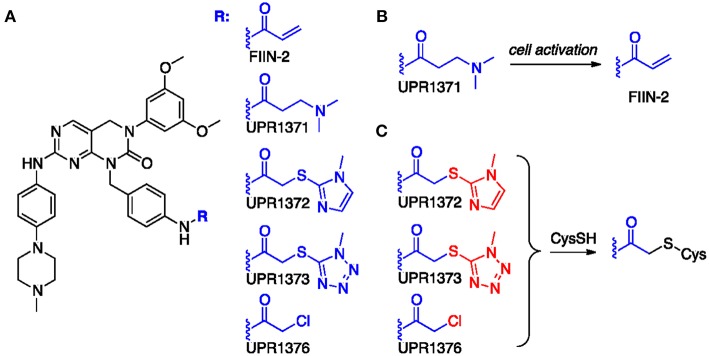
(A) Chemical formulas of tested compounds. (B) Hypothesized conversion of 3-APA group of UPR1371 in acrylamide of FIIN-2. (C) Putative mechanism of action for acetamide derivatives UPR1372, UPR1373 and UPR1376. The leaving group installed on the acetamide fragment is colored in red.